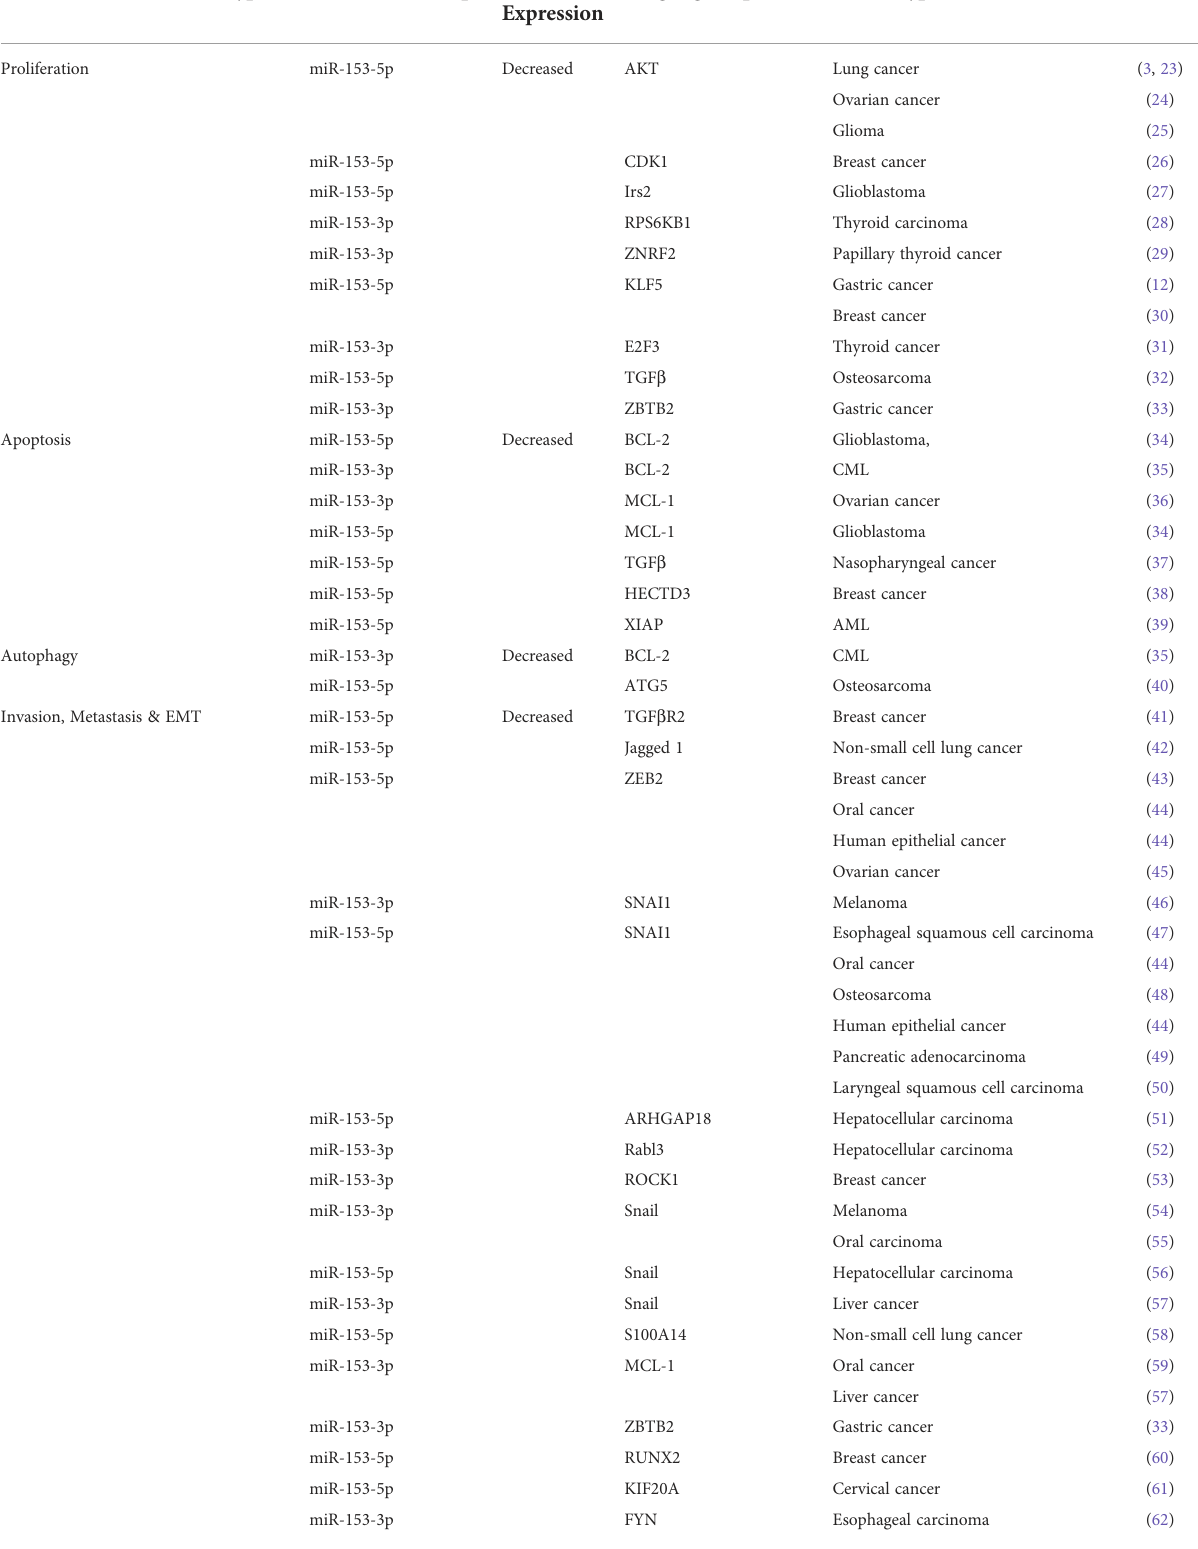
TABLE 1 Tumor suppressor role of miR-153 in different cancer